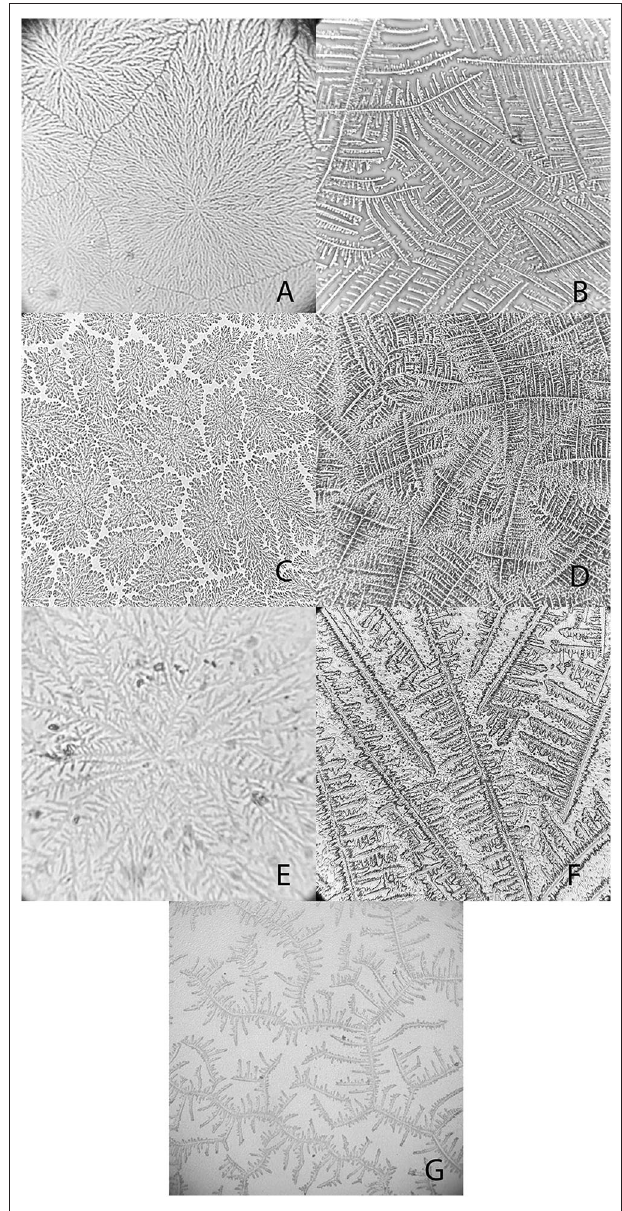
FIGURE 4 | Examples of tear crystallization patterns in wild animals, graded according to Rolando and Masmali scales. (A) Ara ararauna —type I (Rolando) and grade 0 (Masmali) with uniform crystallization pattern and no spaces between branches. (B) Amazona aestiva —type II (Rolando) and grade 2 (Masmali); the main branches are coarse and the secondary branches are far from each other; there are spaces between the crystals. (C) Tyto alba —type I (Rolando) and grade 0 (Masmali); main branches are coarse and short; dense crystallization made up of branched crystals with no spaces between them. (D) Rupornis magnirostris —type II (Rolando) and grade 2 (Masmali); the main branches are more distant and less delicate; space between the crystals. (E) Chelonoidis carbonaria —type II (Rolando) and grade 1 (Masmali); the main branches are coarse and elongated; there are spaces between the secondary branches and the overlap. (F) Caretta caretta —type II (Rolando) and grade 2 (Masmali); the main branches are elongated and coarse, and the secondary branches are short; there are spaces between the crystals. (G) Caiman latirostris —type III (Rolando) and grade 3 (Masmali); the crystallization is thicker, and the crystals are more distant from each other compared to the other studied